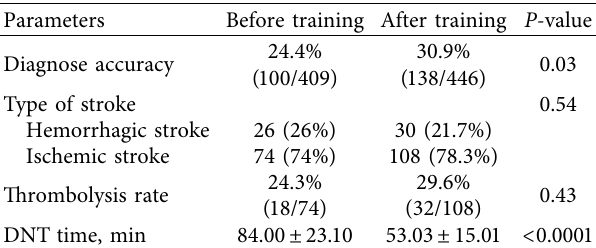
Table 2: Comparison of stroke-related clinical parameters before and after